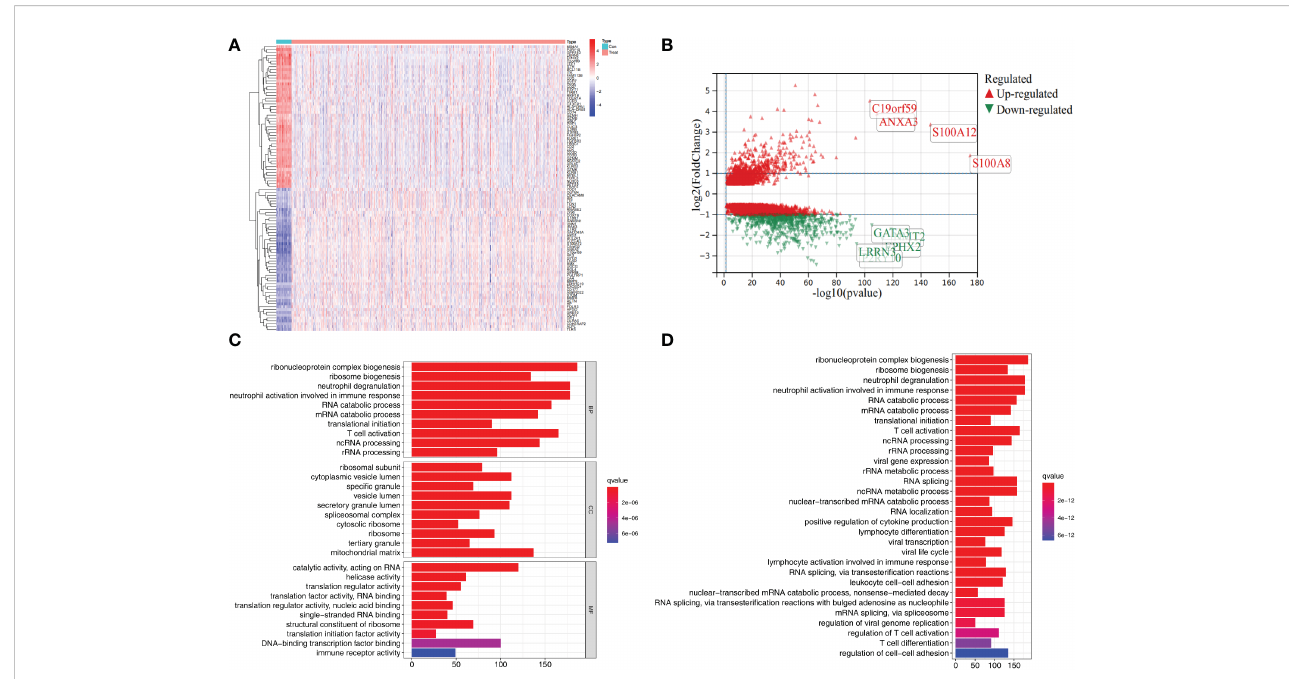
FIGURE 1 Differential gene expression and functional enrichment analysis in the GSE65682 dataset. (A) Heat map showing top 50 differential expression genes in control and sepsis. (B) Volcano plots showing differential expression genes (logFC>0.5). (C) GO enrichment results of differential expression genes. (D) KEGG pathway enrichment analysis of differential expression